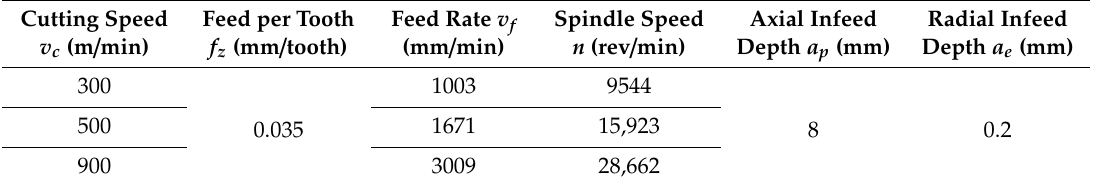
Table 3. Research plan with one variable.